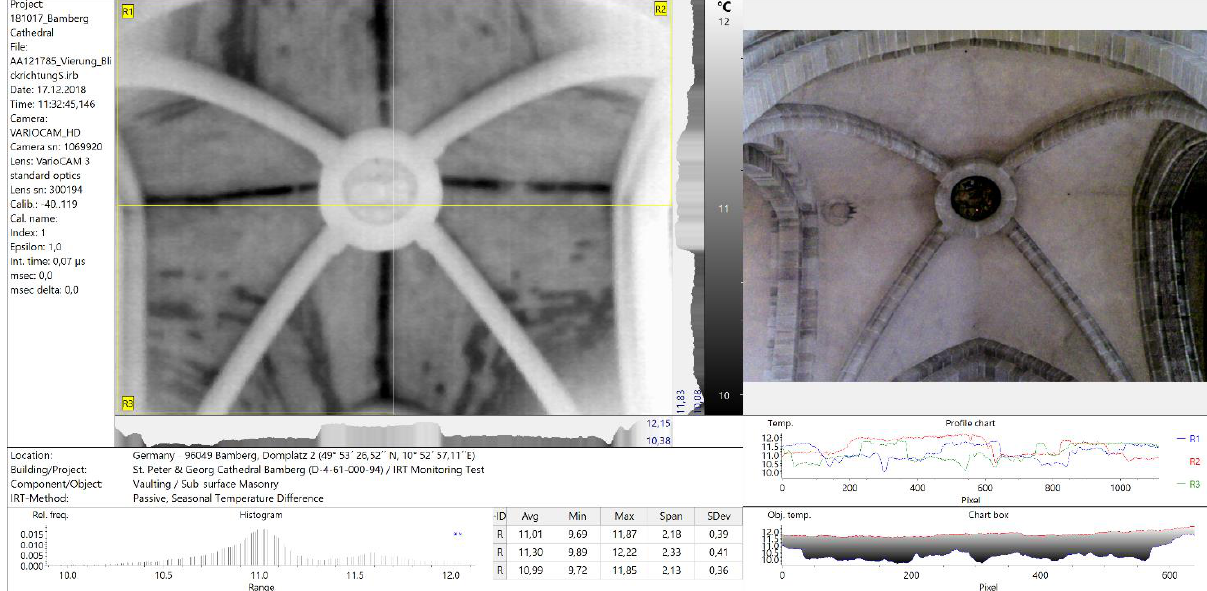
Figure 5: Greyscale visualisation and radiometric measurements of the vaulting structure over crossing of transept and aisle, depicting masonry construction, variations in fabric, stone sizes and pattern.